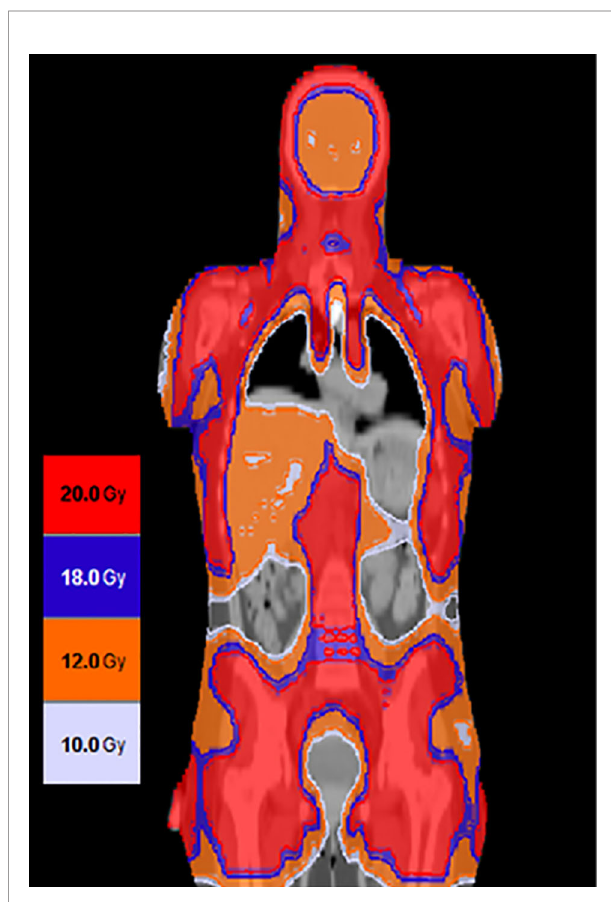
FIGURE 7 | Using targeted dose delivery radiation doses as high as 2000 cGy can be safely delivered to bone and lymph nodes and up to 1200 cGy to liver spleen and